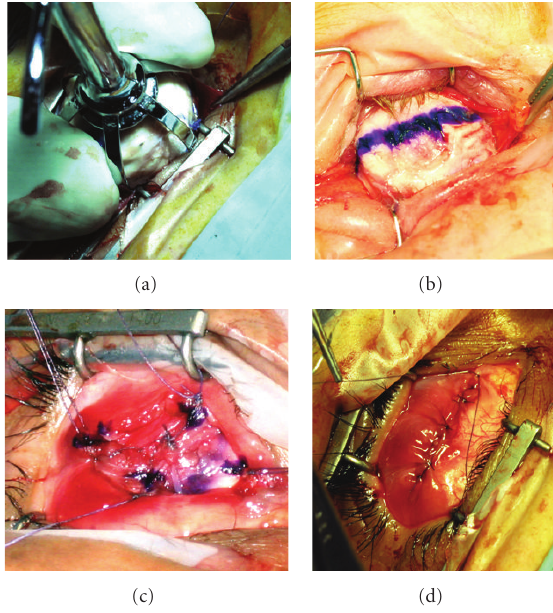
Figure 2: Insertion of the bioceramic prothesis. (a) The partially covered implant is inserted. (b) The marked pole is in front. (c) The four rectus muscles are sutured on the posterior Tenon’s fascia. (d) The conjunctival layer of the suture is